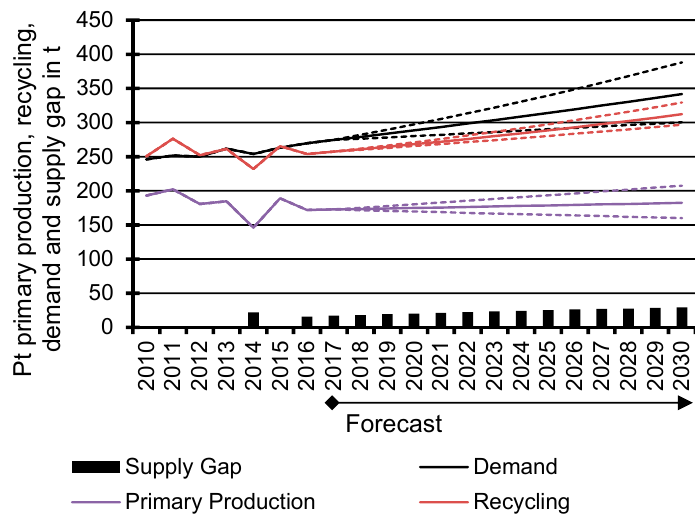
Figure 9. Primary production, recycling, demand and supply gap of Pt from 2010 to 2030. Forecast from 2017 onwards is based on compound annual growth rates (CAGRs) derived from reported estimates by Jolie [15]. Dashed lines present a deviation of the respective CAGR by ± 1%-points.